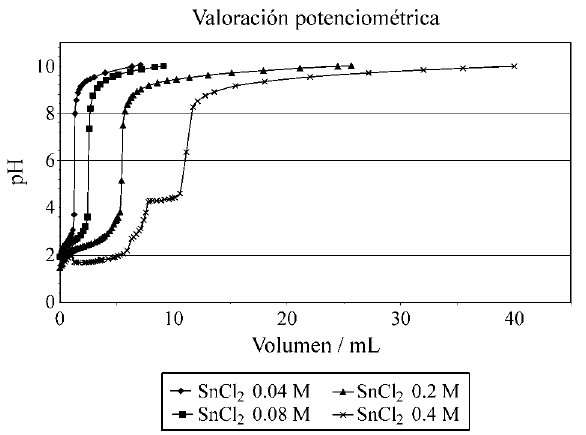
Figura 2. Curvas potenciométricas para diferentes concentraciones de SnCl 2